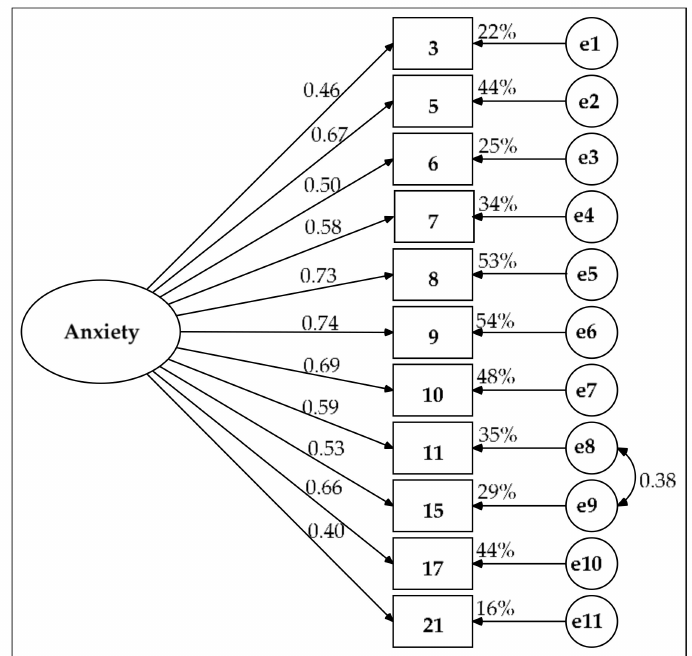
Figure 2. Single-factor model estimated by the maximum likelihood (ML) method in the subsample of 219 participants. Measurement residuals: e1 to